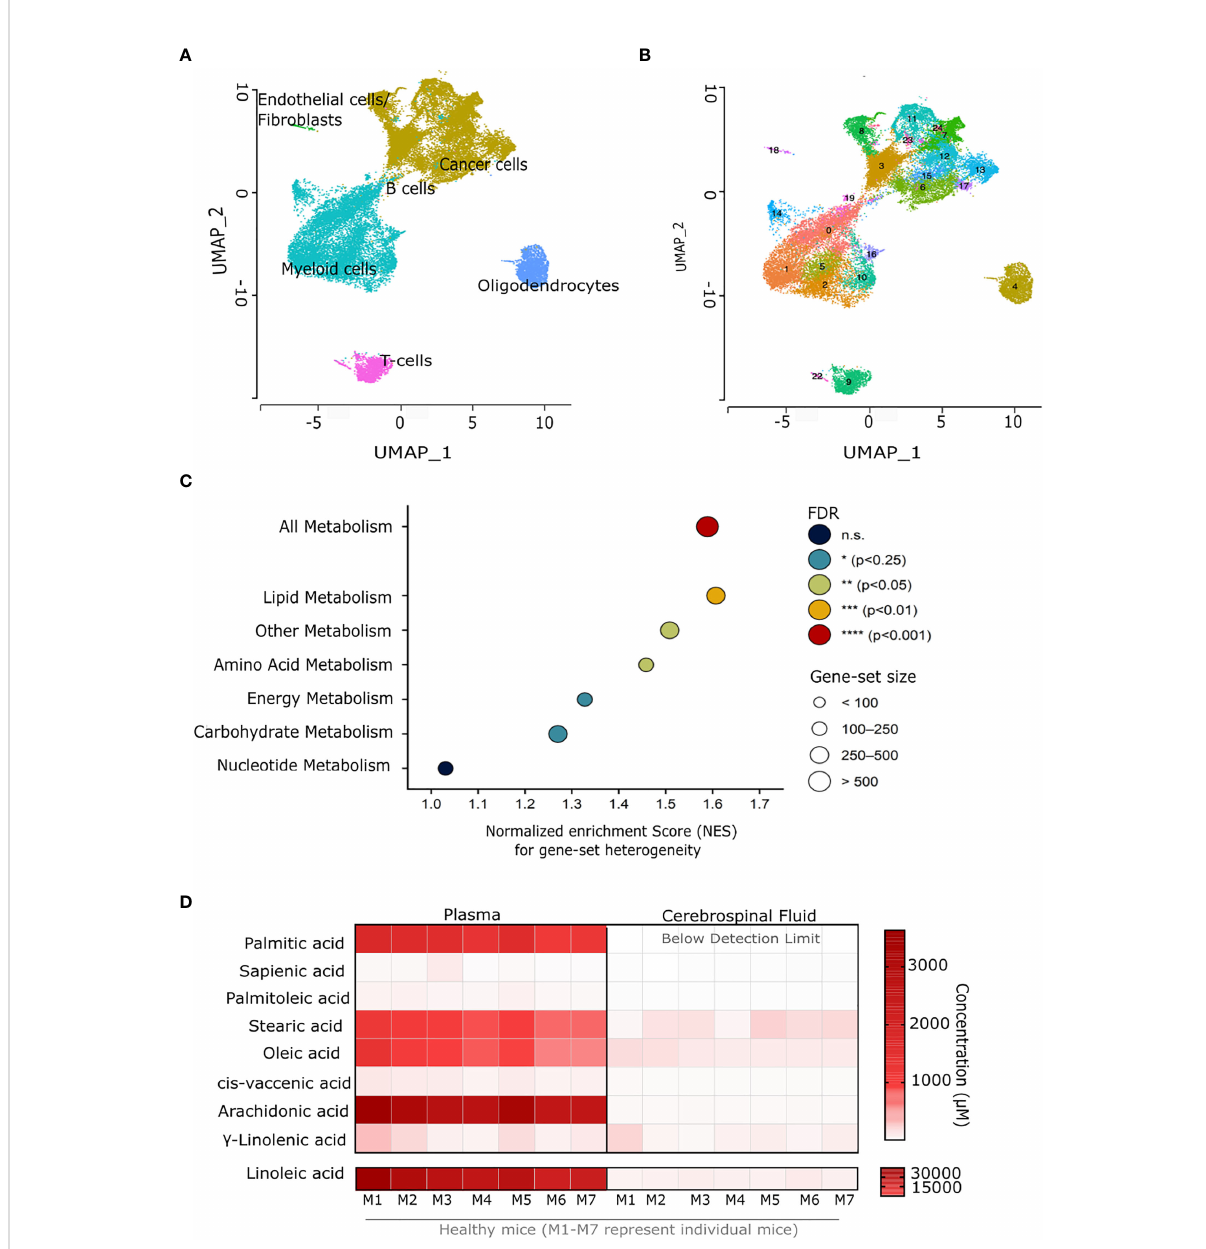
FIGURE 1 Glioblastoma cancer cells have a highly heterogeneous lipid metabolism. (A) Uniform manifold approximation and projection (UMAP) plots of single-cell RNA sequencing data of fresh GBM tissue derived from six patients newly diagnosed with GBM. (B) UMAP plots of sub-clustering analysis performed on single-cell RNA sequencing data from fresh GBM tissue derived from six patients newly diagnosed with GBM. (C) Results of GSEA-based metabolic pathway-heterogeneity analysis for GBM cancer cells. The y-axis indicates the different KEGG-based gene sets included in the analysis (see Methods), whereas the x axis represents the normalized enrichment scores determined for each gene set based on pre-ranked GSEA. Input genes were ranked based on their standardized variances across all cancer cells in sub-clusters of interest (SC: 6, 7, 8, 11, 17) among those in Figure 1B. False discovery rate (FDR)-adjusted p values are indicated by the color scale, with gene-set sizes indicated by the dot areas. (D) Total fatty acid concentration ( m M) in blood plasma and cerebrospinal fl uid from 7 C57BL/6J mice (M1-M7 represent individual mice). n.s., not signi fi